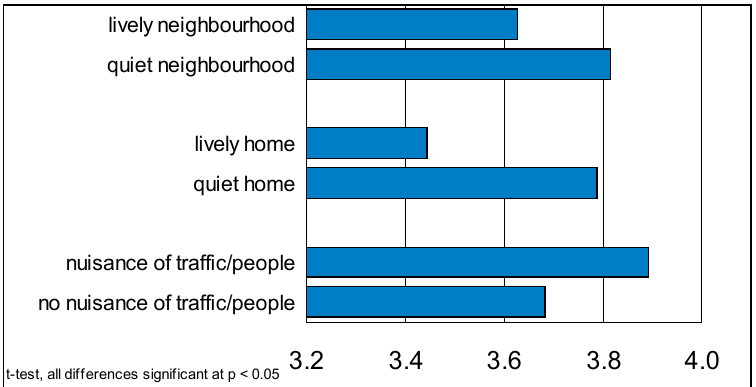
Figure 4. Need for quiet in lively or quiet neighbourhood and home, and nuisance from traffic noise or